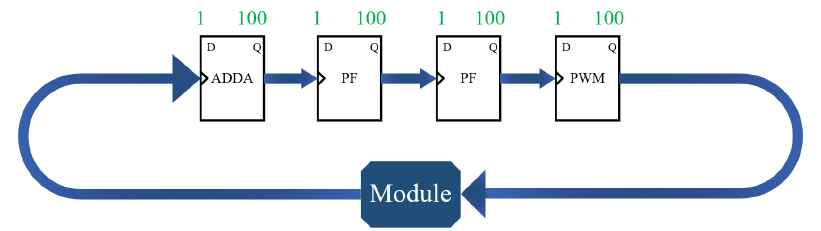
Figure 11. Pipeline control timing